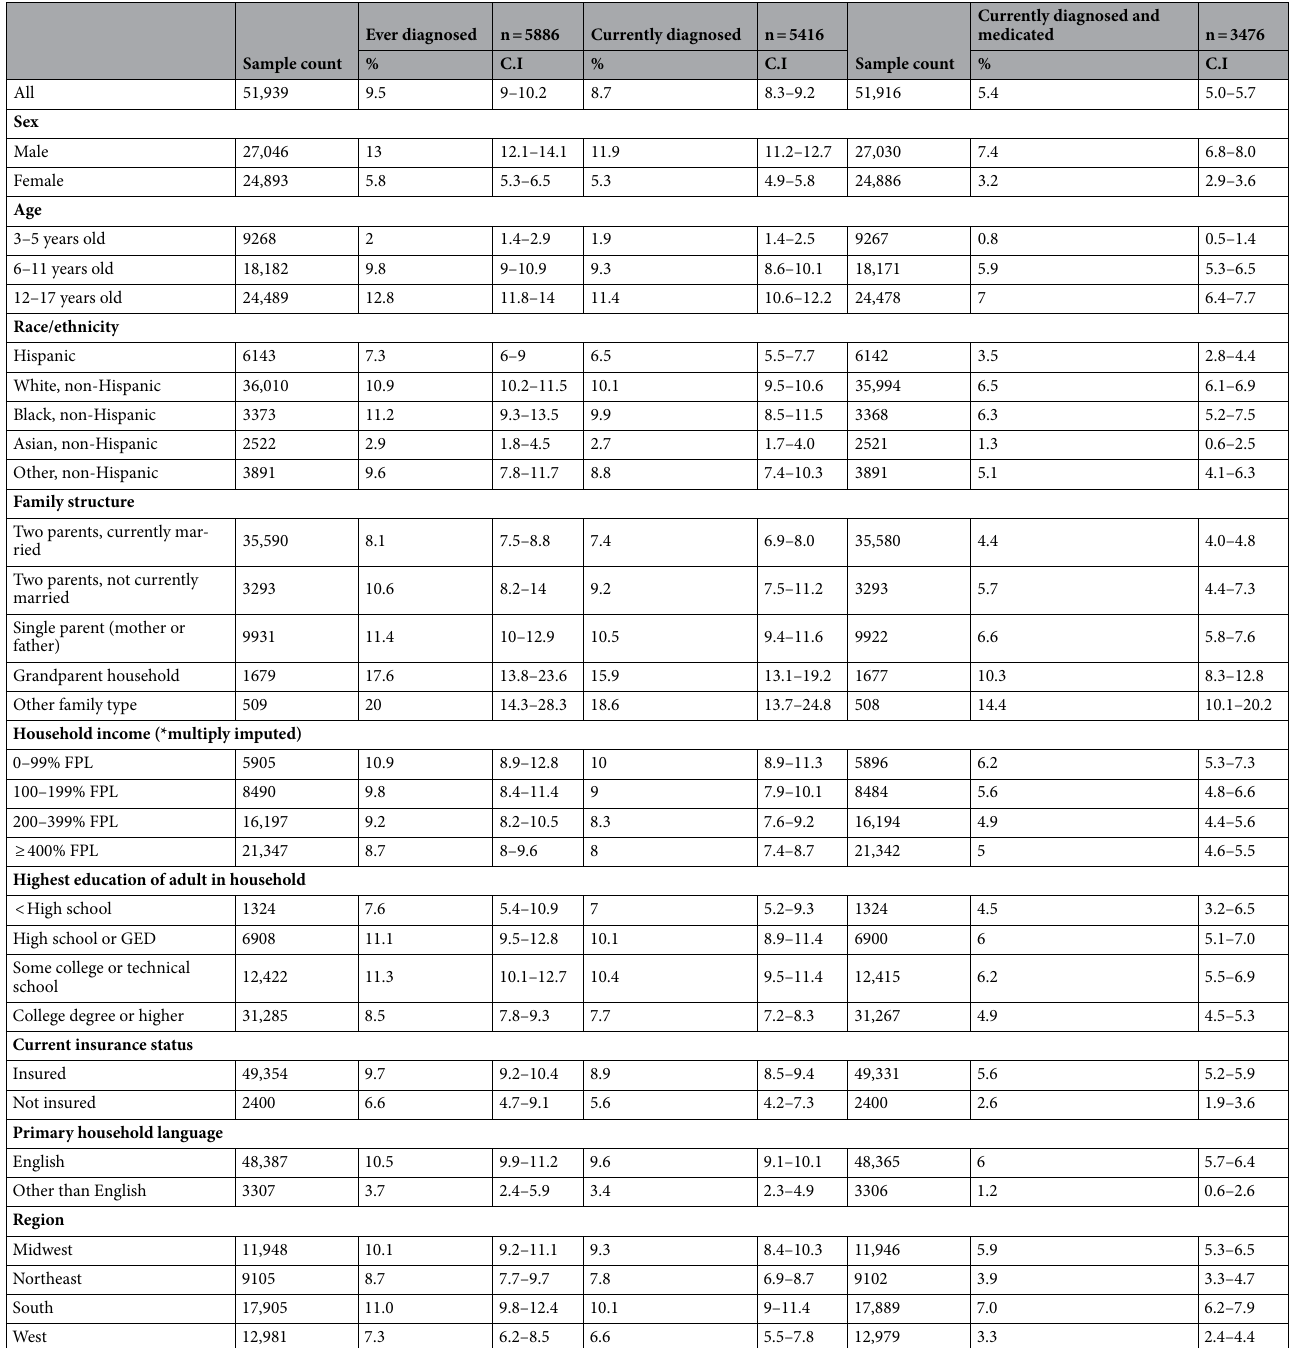
Table 2. Demographics by ADHD status, as counts of the NSCH sample and as estimated percentages of the United States 3–17-year-old population, from 2018–2019. GED stands for General Educational Development. *Percent of Federal Poverty Level (FPL) was multiply imputed for